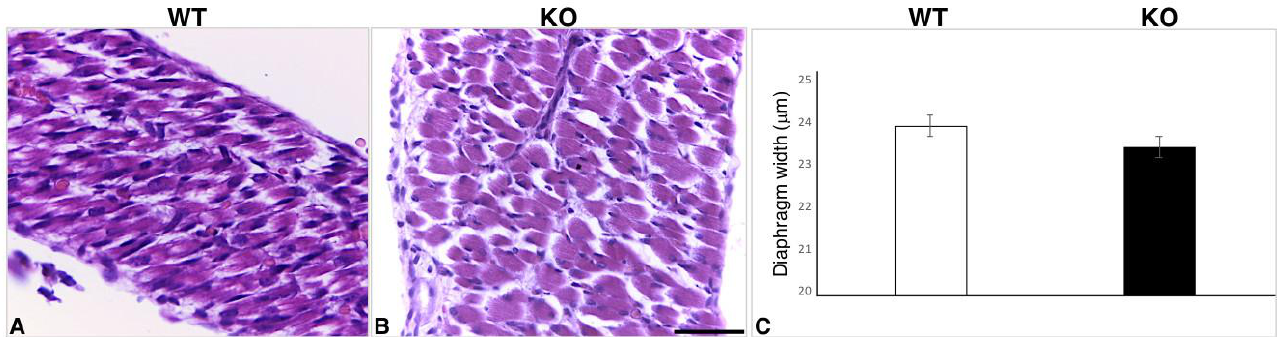
Figure 4. Histological analysis of embryonic skeletal muscle tissues in Hipk2 -KO mice. Representative images of H&E- stained diaphragms from WT and Hipk2 -KO embryos at 17.5 days post-coitum (dpc). ( A , B ) Histograms showing width of diaphragm of muscle cells in WT and Hipk2 -KO embryos at 17.5 dpc. ( C ) Results are mean ± S.E.M. Original magnification, 40×. Scale bar = 50 μm.